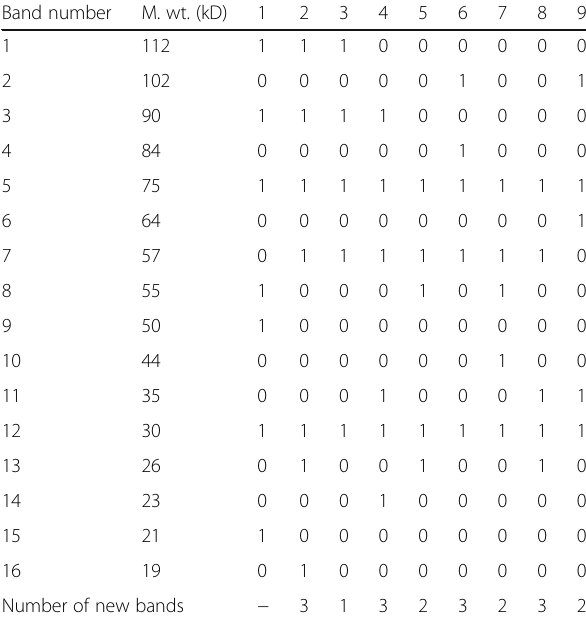
Table 4 Effect of cysteine (0, 20, and 40 mg/l) on element contents (N, P, and K) as (mg/g dry weight) of soybean plant irrigated with saline water (0, 3000, and 6000 mg/l). Results are means of two successive seasons Treatments N P K Salinity (mg/l) Cysteine (mg/l)